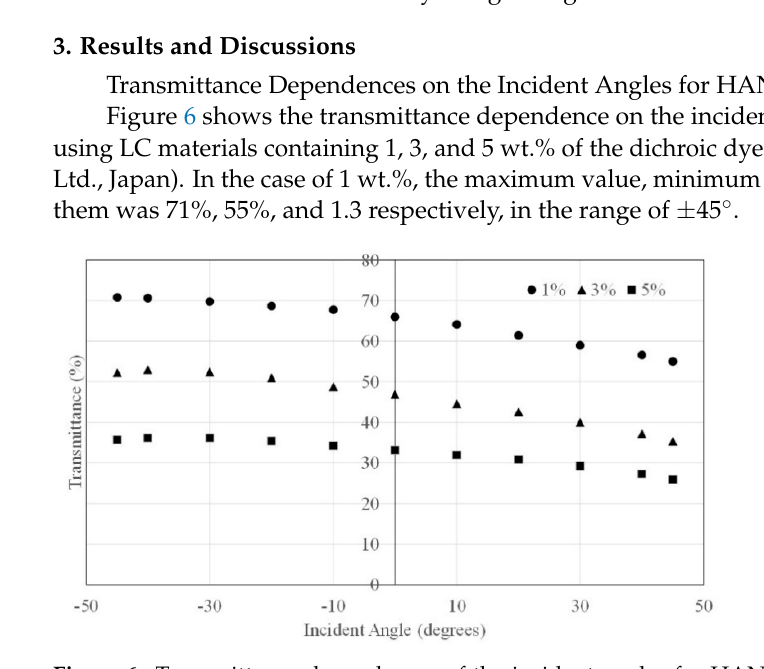
Figure 6. Transmittance dependences of the incident angles for HAN-LCDs using LC materials containing 1, 3, and 5 wt.% of NKX-4173 (Hayashibara Ltd., Japan) dichroic dye.